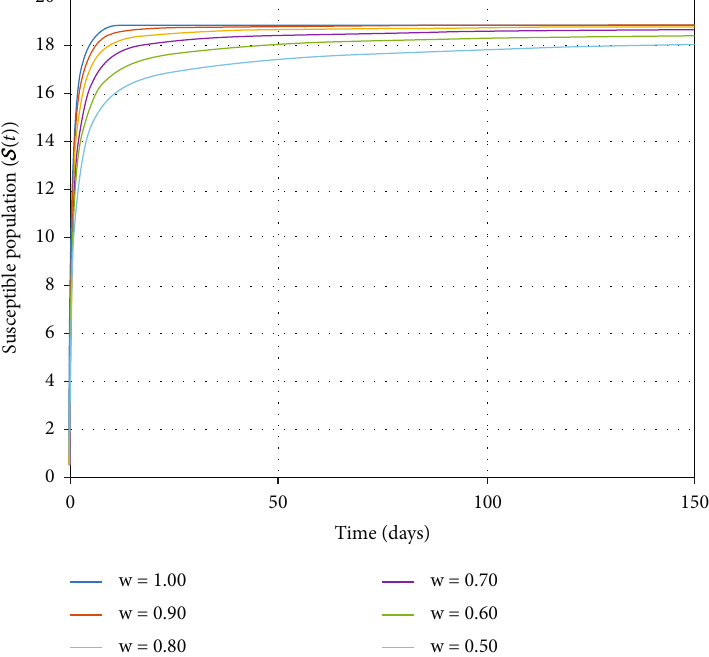
Figure 10: S ð t Þ by changing ω where m = 7 .